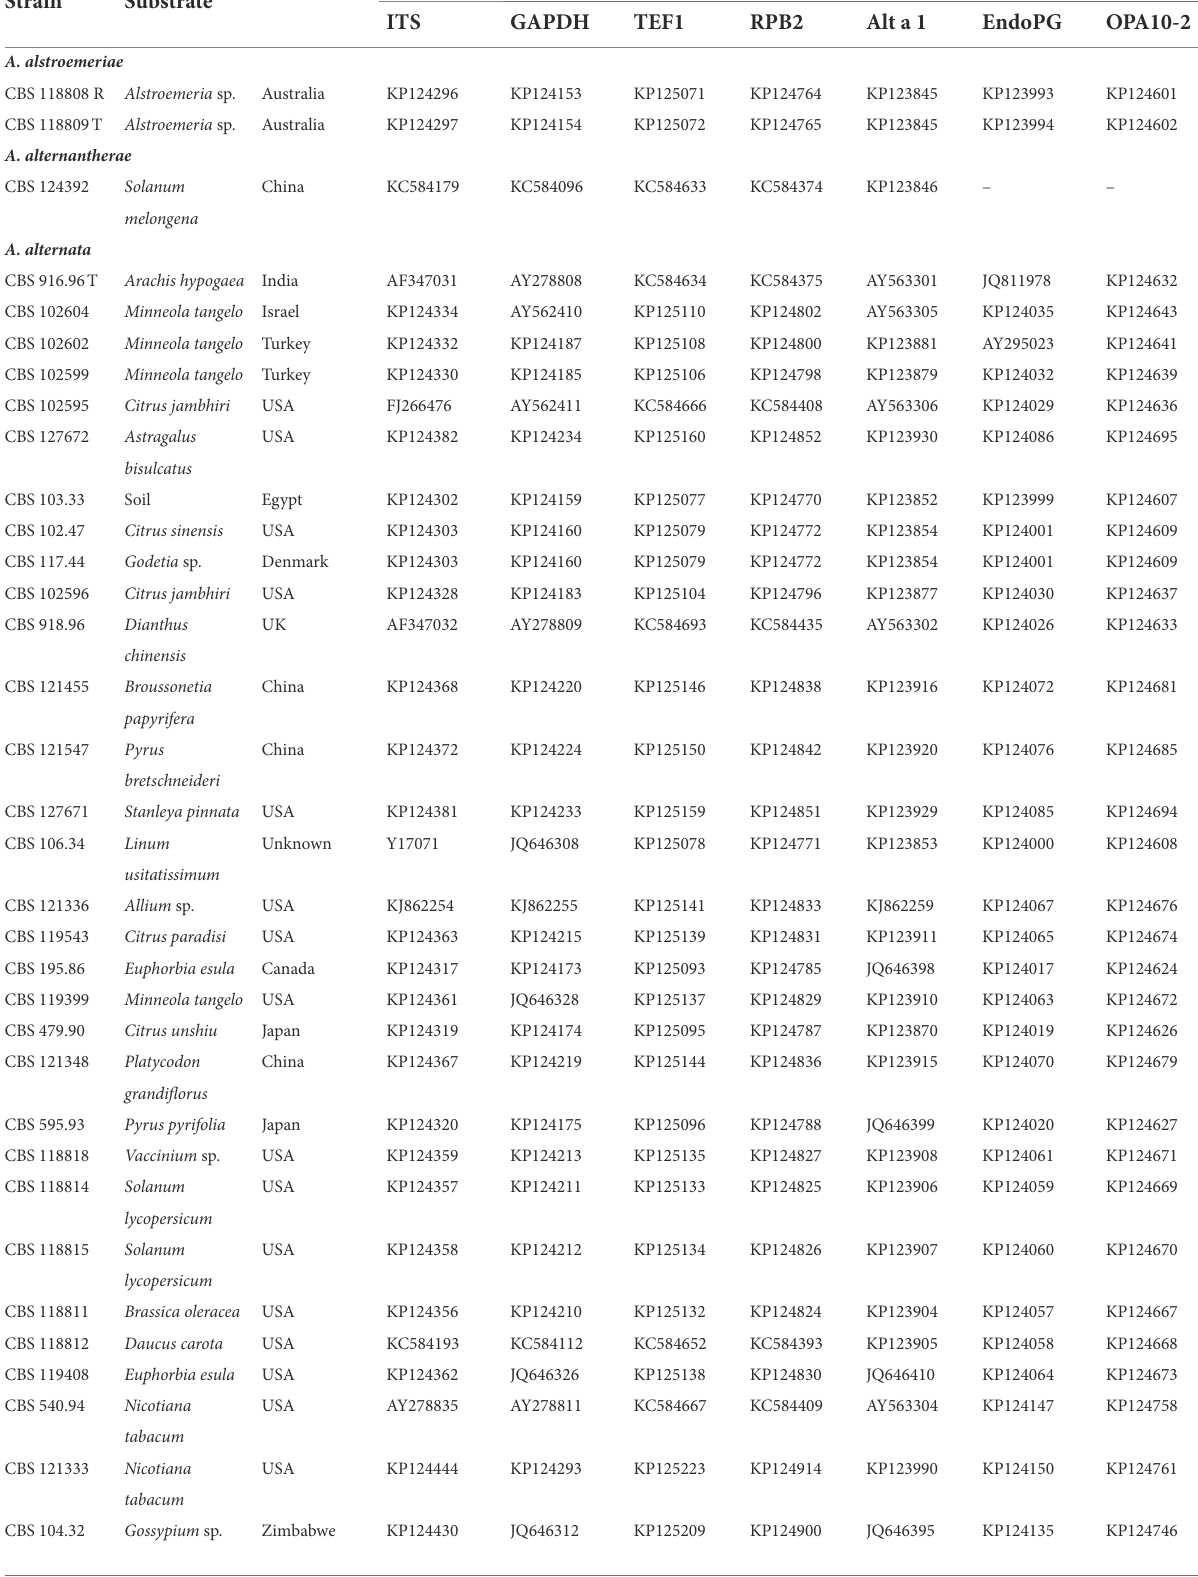
TABLE 2 Alternaria strains used in this study and the GenBank accession numbers. Species/ Host/ Strain